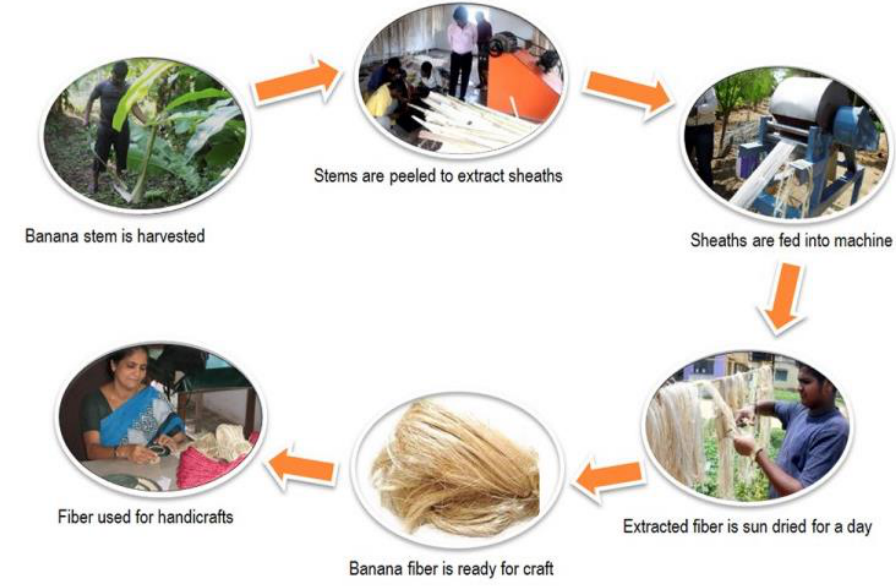
Figure 4. Mechanical separation of fibers from banana stems (adapted from [24]).